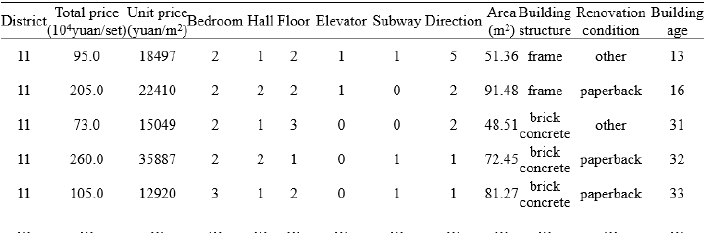
Table 3 Characteristic variables after